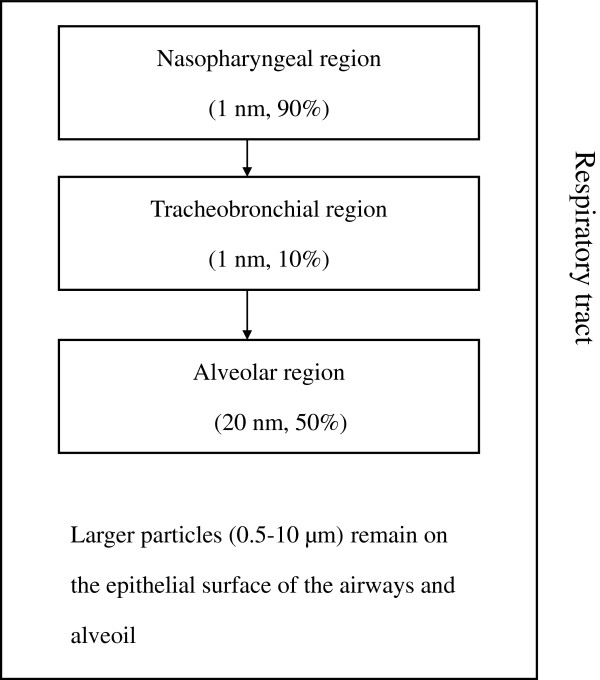
Particulate distribution of TiO2 particles by size through different regions of the respiratory tract. This diagram was derived from an explanation of particulate distribution after inhalation given by Simko and Mattsson [75]. Arrows represent downward movement of particles through the respiratory tract. Most particles in the size range of 1–5 nm are distributed throughout the three regions. 1 nm and 20 nm particles are mostly distributed in the nasopharyngeal region and alveolar regions respectively. 0.5-10 μm particles remain on the epithelial surface of the airways and alveoli.